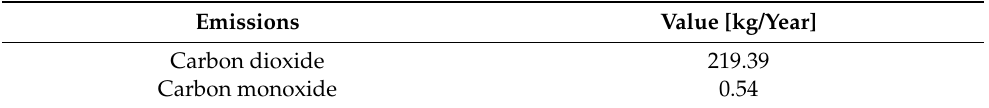
Table 9. Pollutant emissions (iHOGA).